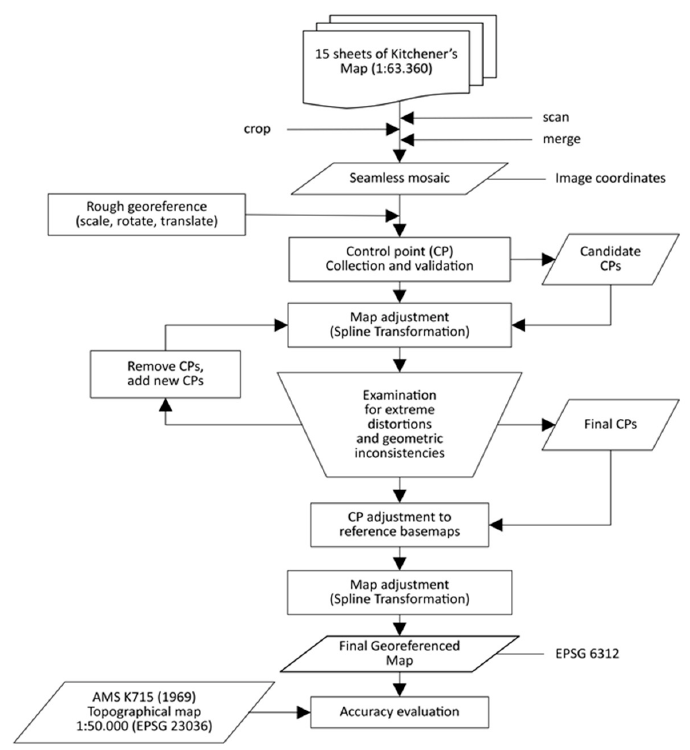
Figure 2. The georeferencing workflow.